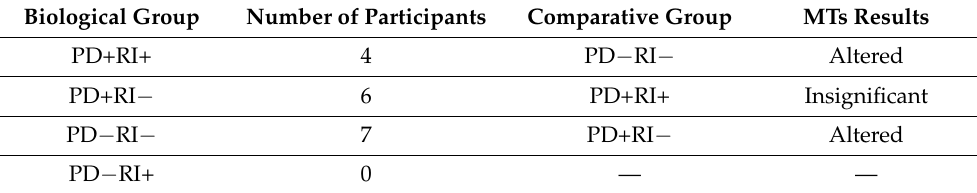
Table 5. Comparison of groups by number of patients in each group and results with respect to MT genes. Biological Group Number of Participants Comparative Group MTs Results